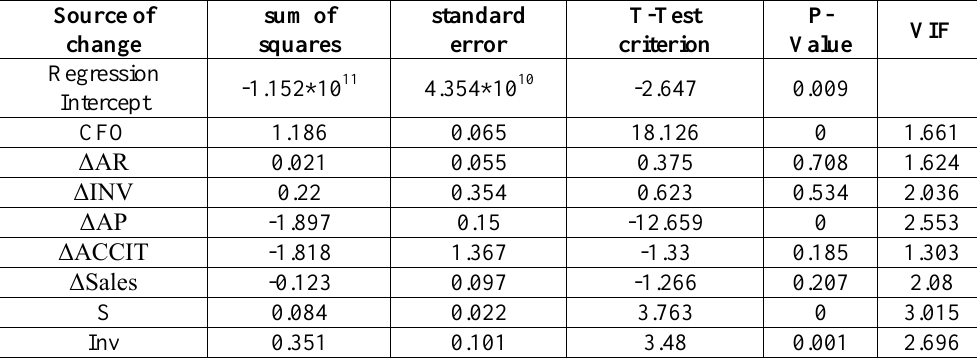
Table 9. Accrual regression coefficient analysis for 2017